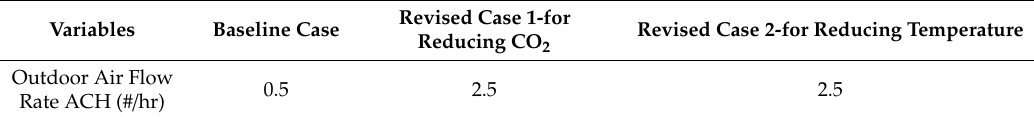
Table 3. Summary of Changed Variables Between Baseline Case and Revised Case.